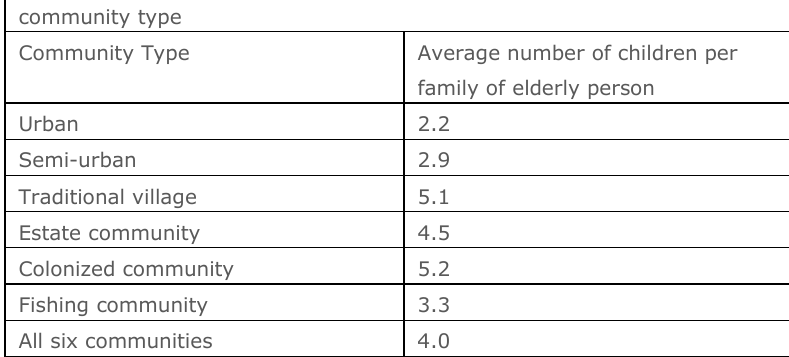
Table 4: Average number of children per family of elderly person